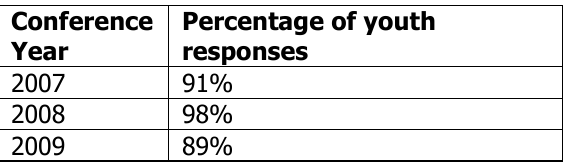
EYC attendees who expressed that the conference provided specific information and concrete actions to improve the environment in their